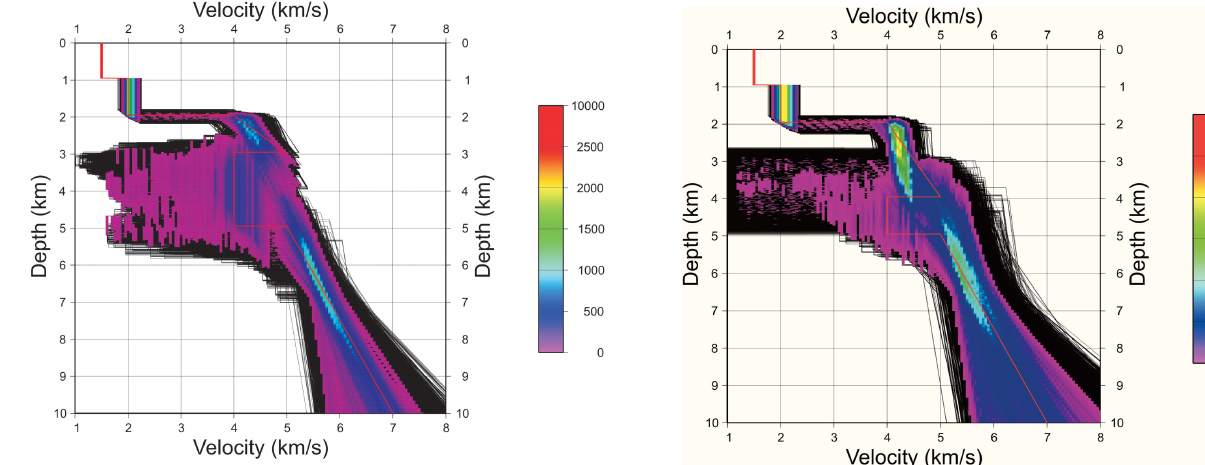
Fig. 17. Results obtained after using the Metropolis algorithm on data from model 2 and 10Hz for 40000 cases considering more picks than in the previous case (Fig. 16). Red line represents the real model and every black line a modified model. The colour scale stands for the number of times that a model (or part of it) is visited.